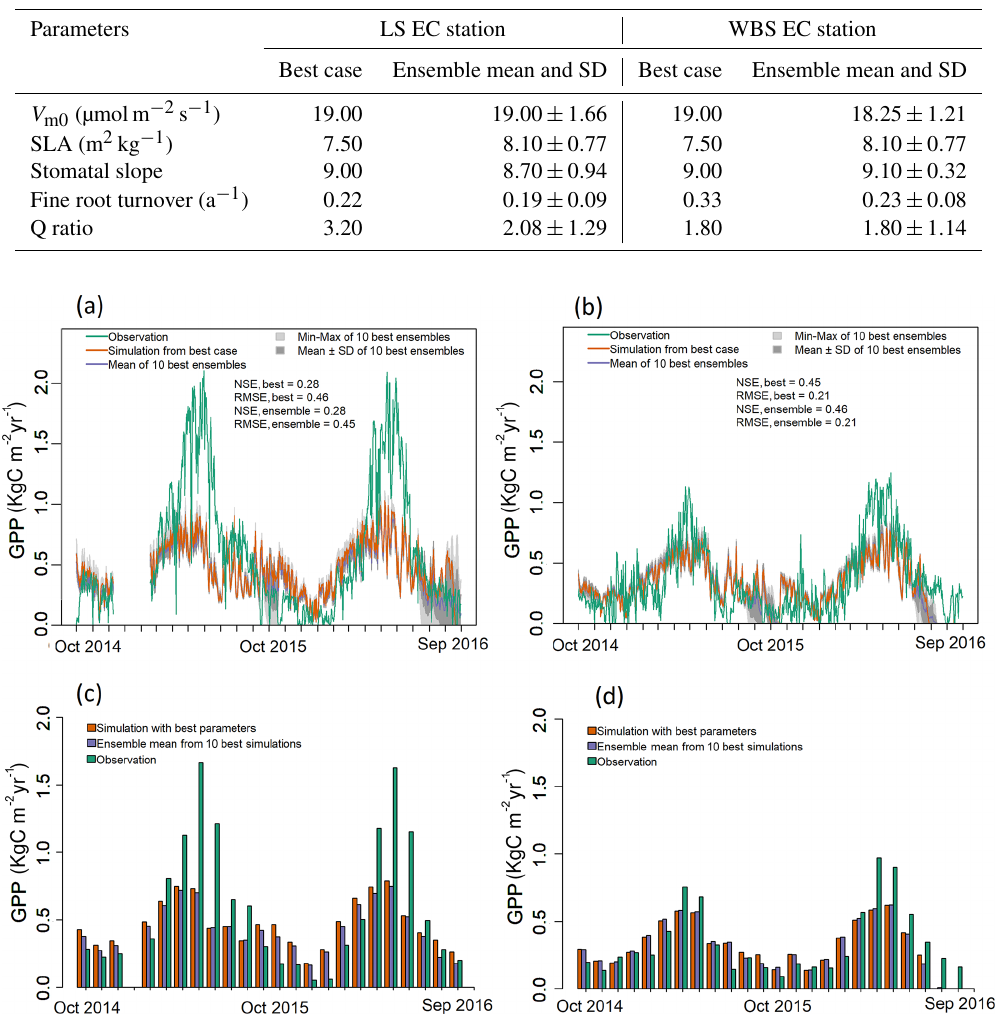
Figure 3. Observed and simulated GPP for the optimization period (water years 2015 and 2016) for both EC towers. (a–b) Simulated daily GPP (kgCm − 2 yr − 1 ) from best case, 1 standard deviation of ensembles, and range of ensemble simulations compared with observations for (a) LS and (b) WBS sites. (c–d) Simulated mean monthly GPP (kgCm − 2 yr − 1 ) from best case and ensemble means compared against observation data for (c) LS and (d) WBS sites. Note that observation data from 11 December 2014 to 17 February 2015 are missing for LS